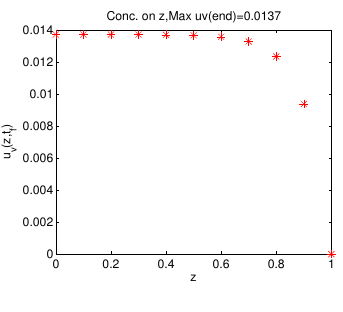
Figure 10. Averaging concentration u v ( r,z,t f ) depending on z for t f = 50